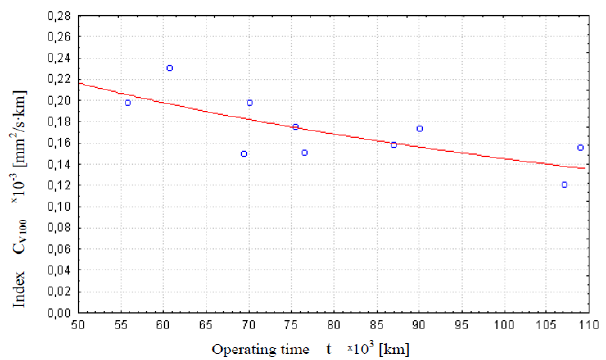
Fig. 4. Course of the change intensity index of coking residues according to Conradson C KOKS as a function of operating time